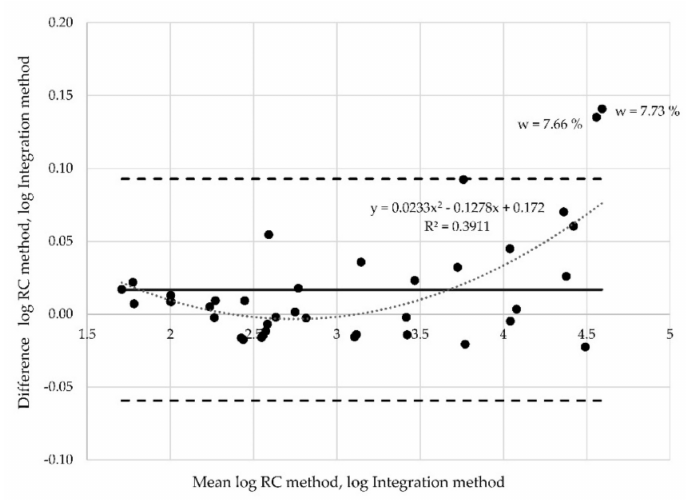
Figure 17. Altman plot for all samples measured at probe “C”—logarithmic transformation.